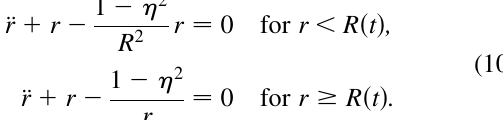
FIG. 7. (Color) Evolution of four collections of 1600 test-particle orbits. The collections start (with zero initial particle velocity) at x (cid:2) 0 : 31 (cid:21) 0 : 002 , x (cid:2) 0 : 70 (cid:21) 0 : 002 , x (cid:2) 1 : 1 (cid:21) 0 : 002 , and x (cid:2) 1 : 41 (cid:21) 0 : 002 with t (cid:2) 0 , hj (cid:22)! ji (cid:2) 0 : 001 , (c) (cid:13) (b) (cid:13) 1 hj (cid:22)! ji (cid:2) 0 : 01 . (g) Phase mixing in an envelope-mismatched beam; the mismatch M (cid:2) 1 : 1118 compares to a mode amplitude (cid:2) 0 : 05 , and hj (cid:22)! ji (cid:2) 0 : 01 (cid:13) 1